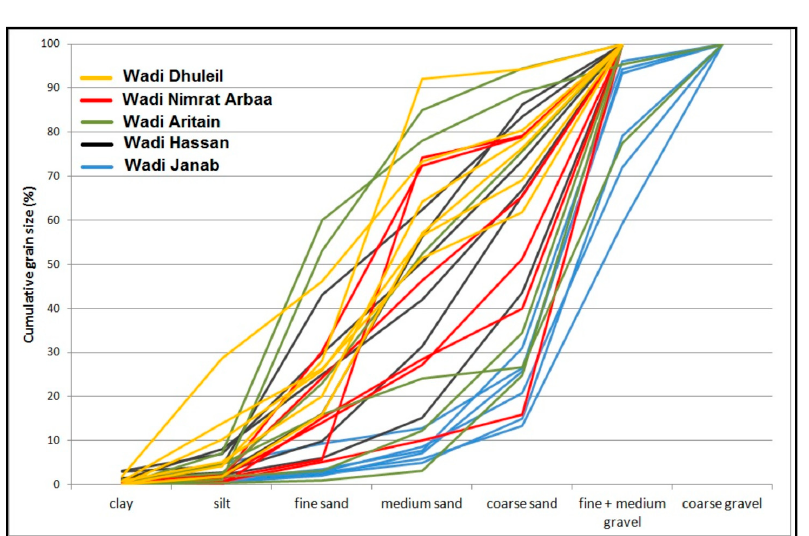
Figure 4. Cumulative grain size distribution of all the soil samples based on Reference [23].